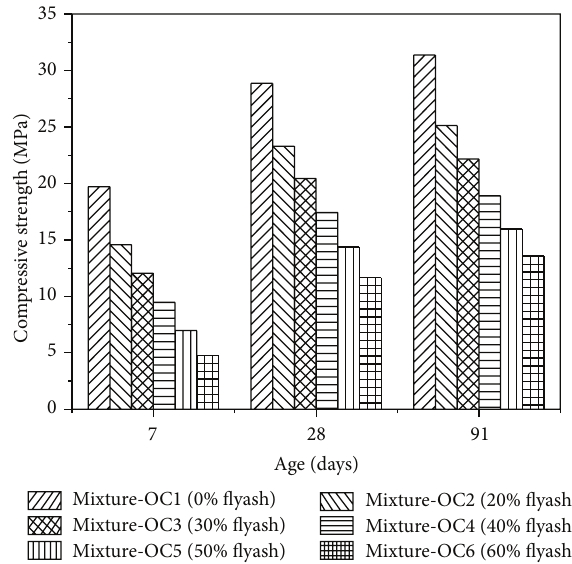
Figure 2: Compressive strength versus age.